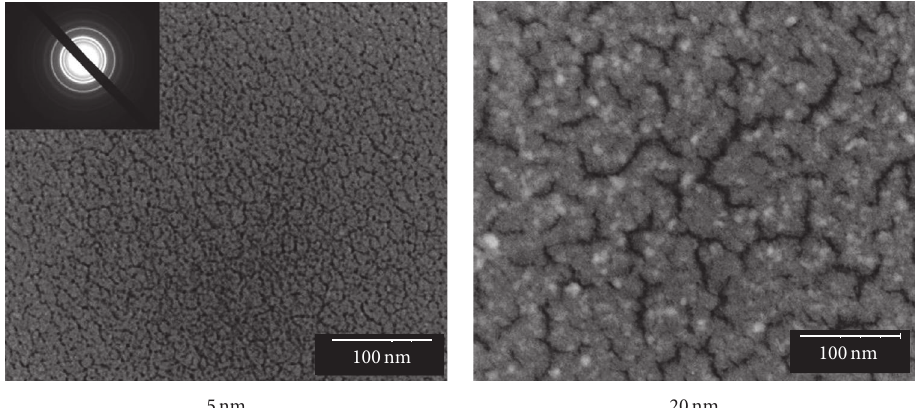
Figure 2: Electron microscopy images of the structure of VN 𝑥 films at different deposition stages. The given film thicknesses are all estimated values. The figures present the negative images for better visualization of the grain boundaries and pores.